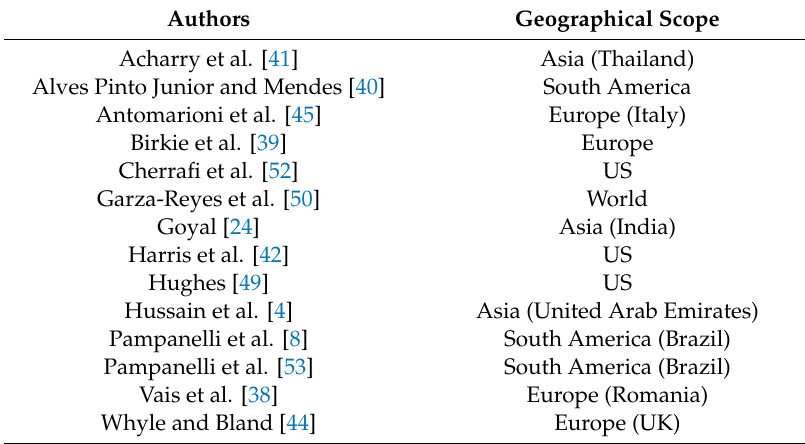
Table 7. Geographical